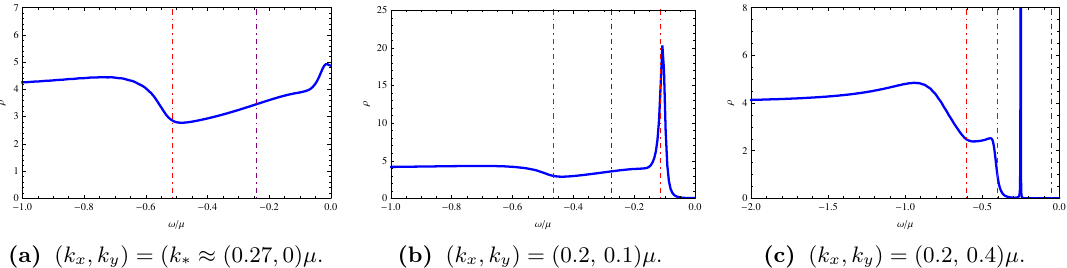
Figure 3. The spectral function as function of ! for di(cid:11)erent ( k x ; k y ), at low temperature T = p 0 : 20 T c and (cid:21) = 1 = (8 2). The dashed vertical lines represent the position of the IR (in red) and UV (in violet) Dirac